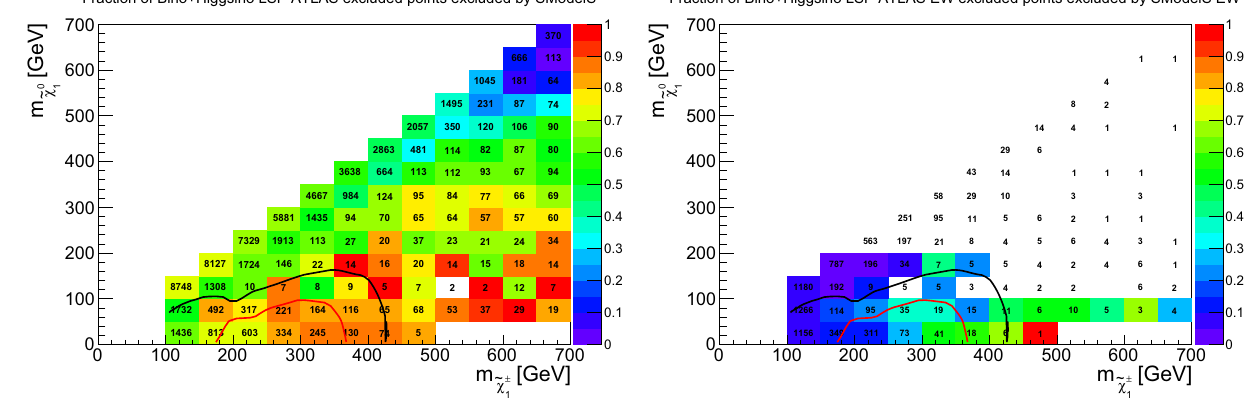
Fig. 11 Coverage in the chargino vs. neutralino mass plane, for ˜ χ ± masses up to 700 GeV. Here, bino-like and higgsino-like LSP scenar- ios have been combined to increase the number of points. The plot on the left considers all analyses, the plot on the right only EW analyses. The color code indicates the fraction of points excluded by SModelS